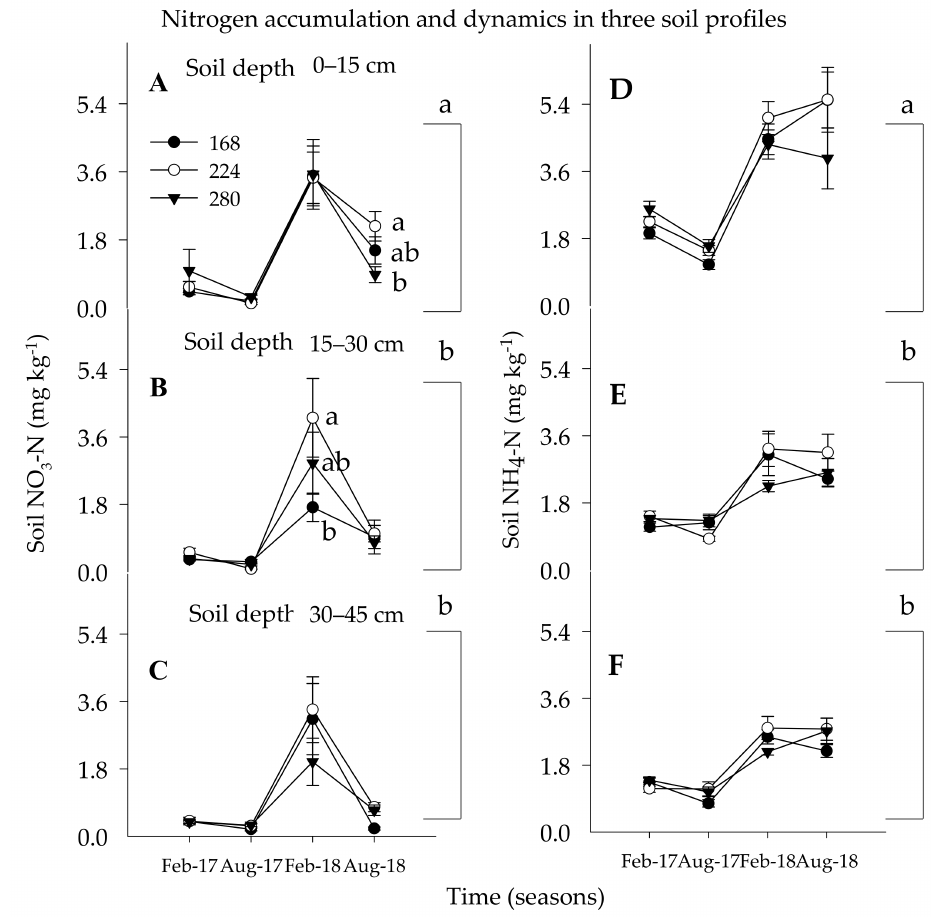
Figure 1. Soil available N (soil NO 3 -N: figures ( A – C ) and soil NH 4 -N: figures ( D – F )) accumulation and dynamics under Huanglongbing-affected citrus trees as impacted by three nitrogen rate (168, 224, and 280 kg ha − 1 ) in spring (sp, Feb. /Mar) and summer (su, Aug. /Sept.) 2017 and 2018 seasons in three soil depths (0–15, 15–30, and 30–45 cm). Means followed with the same lower case letters on a vertical alignment is not significantly different ( p ≤ 0.05) using Tukey’s range test ( n =